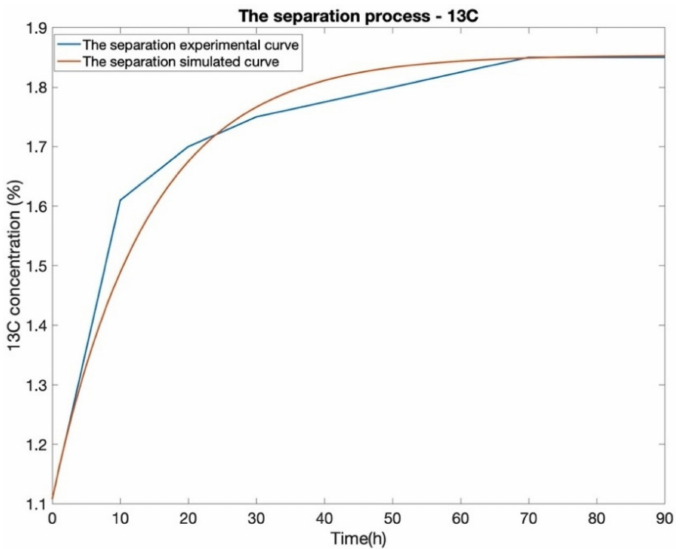
Figure 24. The separation process experimental curve and the most probable approximating response of the separation process (the case of the second